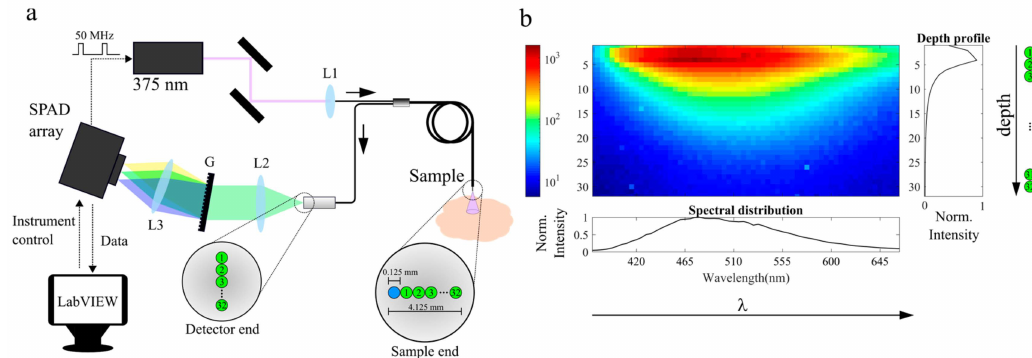
Figure 1. ( a ) The optical layout of the instrument and fiber arrangement at the sample and detection ends and the electronic chain for instrument control, synchronization, and data acquisition. The dashed arrows indicate electronic connections. The excitation fiber is highlighted in blue; the detection fibers are numbered and highlighted in green. Numeration of the fibers increases with the distance to the excitation fiber. At the detection end, the fibers are arranged vertically and perpendicularly to the long axis of the Single Photon Avalanche Diode (SPAD) array. Detection fibers are imaged with a 1:1 magnification onto the SPAD detector. The distance to excitation fiber increases from top to bottom as indicated by the numeration. Fluorescence light is dispersed and spectrally resolved across the long axis of the detector using a transmission grating comprising 600 grooves / mm. L1: Aspheric lens, f = 11.0 mm (A220TM, Thorlabs); L2 and L3: Bi-Convex Lens, f = 60.0 mm (LB1723-B, Thorlabs). ( b ) An intensity map measured in the SPAD array for a representative fluorescence measurement of formalin-fixed rabbit aorta: The fluorescence intensity variation with depth and wavelength are plotted on the right and bottom, respectively. Table 1. The time-gating strategy for fluorescence lifetime measurements of fluorescence standards and biological tissue. Reference Fluorophores Tissue Measurements Gate